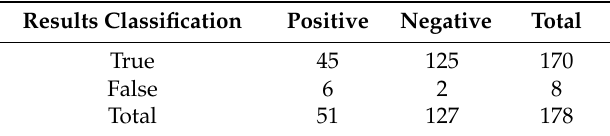
Table 5. Performances of the sensor in the detection of a multiple occupation of the nest during an